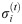
Coding multiple stimuli with amplified transient trajectories.Example corresponding to a N-dimensional Gaussian connectivity matrix with g = 0.9. A. Singular values of the propagator, σi(t), as a function of time (SV trajectories). Dark blue traces show the amplified singular values, defined as having positive slope at time t = 0; The dominant singular value σ1(t) corresponds to the dashed line. Light blue traces correspond to the non-amplified singular values, having negative slope at t = 0. B. Norm of the activity elicited by the first two amplified inputs, i.e. R1*, R2*, (right singular vectors corresponding to singular values σ1(t*) and σ2(t*) at time t* indicated by the dashed vertical line in panel A; purple and red traces), and by one non-amplified input (chosen as R100*, corresponding to σ100(t); orange trace). C. Illustration of the dynamics elicited by the three inputs, R1, R2 and R100 (shown in different rows), as in B. Left: Activity of 10 individual units. Center: Projections of the evoked trajectories onto the plane defined by the stimulus Ri* and the corresponding readout vector Li* (in analogy with the amplified case, we chose the readout of the non-amplified dynamics to be the state of the system at time t*, i.e. L100*). Right: population responses to the three stimuli projected on the readout vectors L1*, L2* and L100*. N = 1000 in simulations.